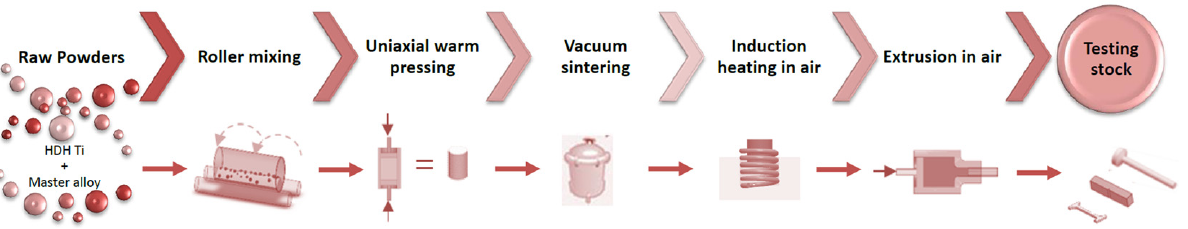
Figure 2. The sequence of operations used to prepare the Ti-6Al-4V alloy bar using a combination of warm compaction, vacuum sintering, and a blended powder mixture extrusion.